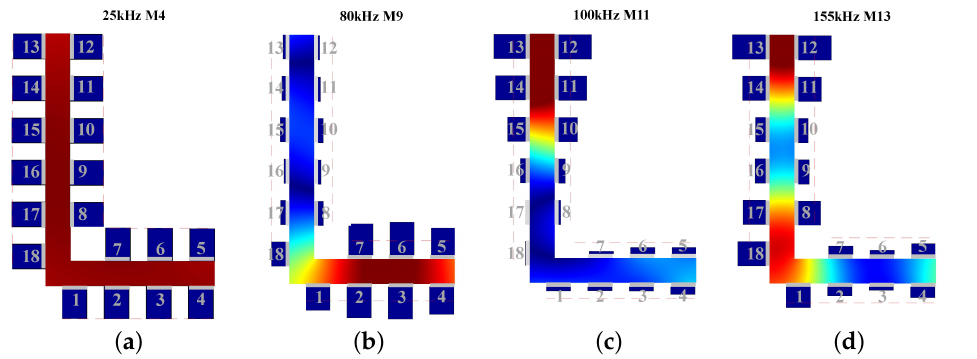
Figure 7. Normalized weight of each transducer: ( a ) 25 kHz M4, ( b ) 80 kHz M9, ( c ) 100 kHz M11, ( d ) 155 kHz M13.